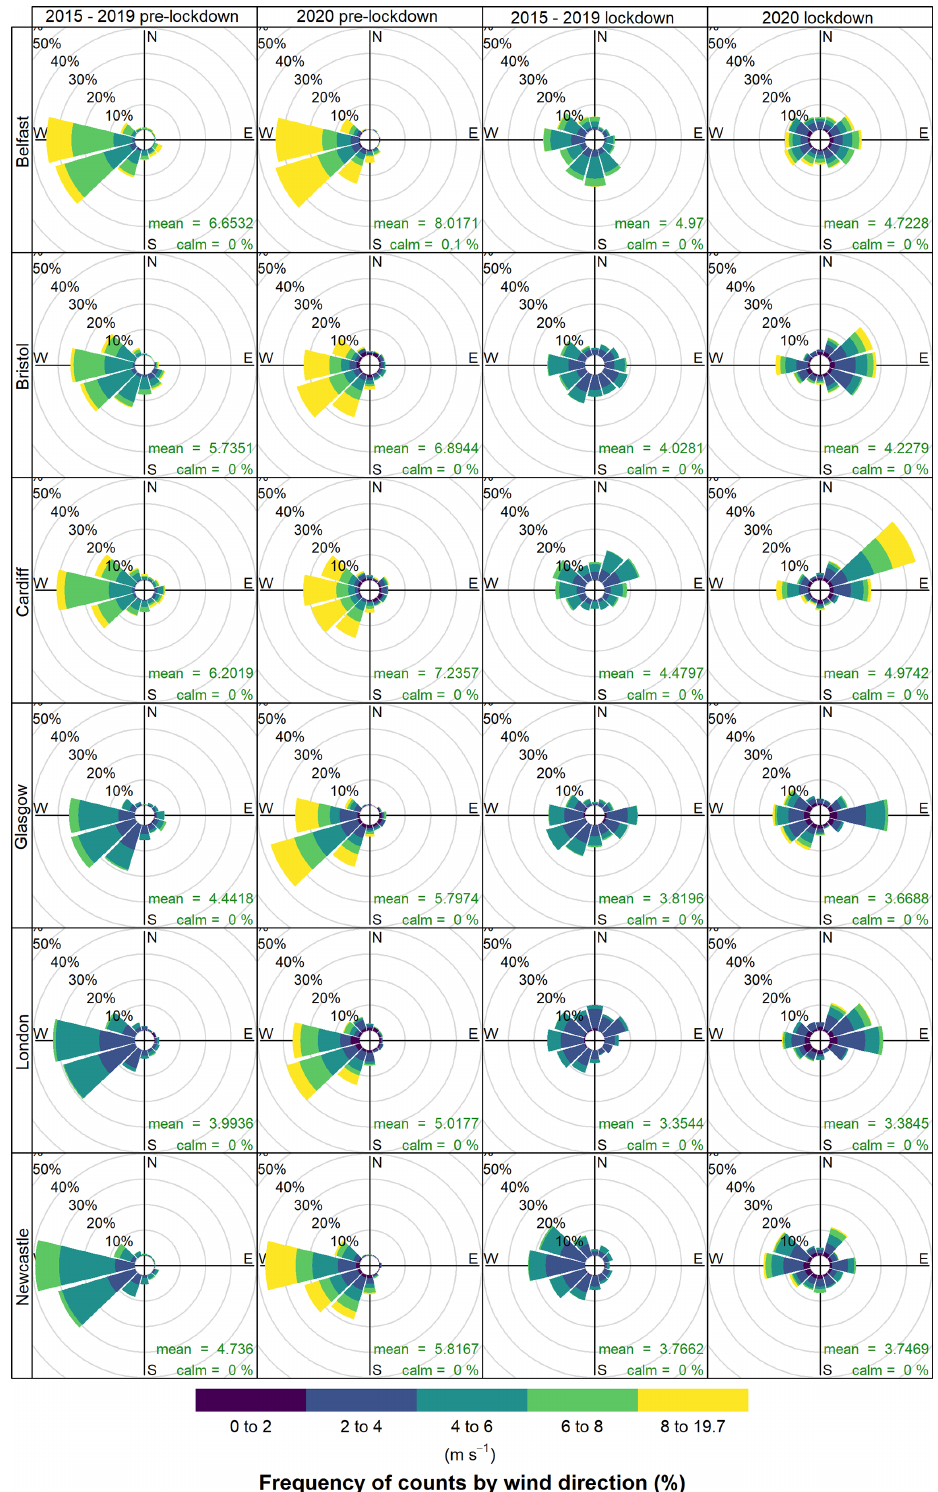
Figure 3. Average wind roses for six cities for pre- and post-lockdown period and lockdown period 2015–2019 and 2020. Data used are modelled using the UK Met Office Unified